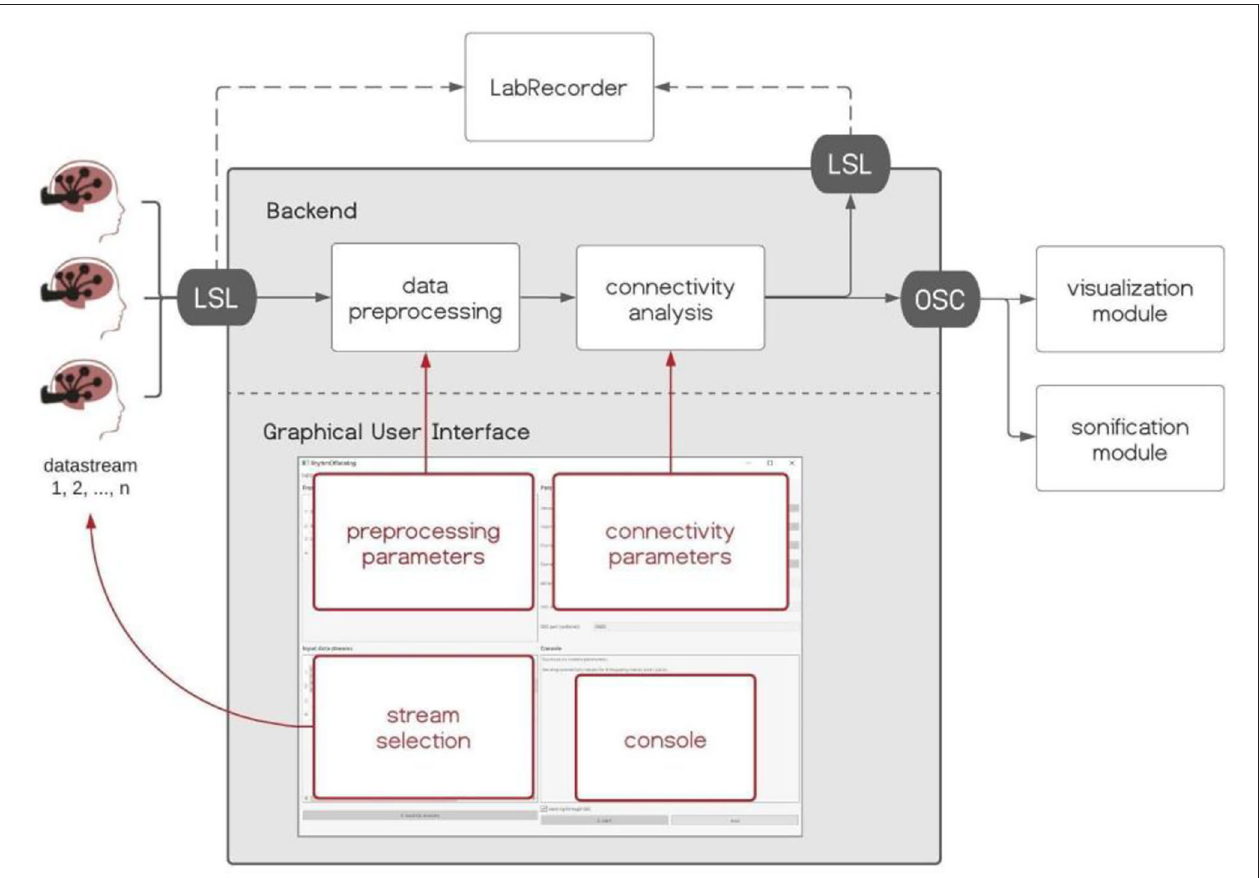
FIGURE 2 | Hybrid Harmony software. The backend and Graphical User Interface (GUI) of Hybrid Harmony are shown in the gray box. Hybrid Harmony performs data preprocessing and connectivity analysis on the incoming EEG data from LabStreamingLayer (LSL), and outputs synchrony values to LSL and Open Sound Control (OSC; detailed in Supplementary Material , The Data Transfer Protocol: Open Sound Control). The output can then be recorded by LabRecorder ( Supplementary Material , Saving Data Through LSL) and be transformed into sensory experiences through the visualization and sonification modules (section Visualization and Sonification). The GUI enables the user to control parameters for preprocessing and connectivity analysis, as well as monitor the program status on the console.